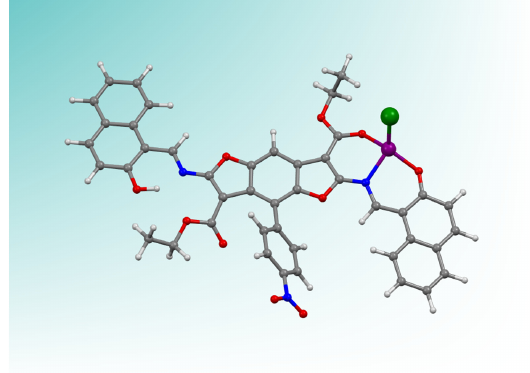
Figure 1. ZnNB model complex as a ball-and-stick representation (zinc–purple sphere). The zinc coordination sphere is based on the analogous X-ray structure of a ligand complex with zinc [30]. The green sphere represents a chloride anion, completing the tetrahedral zinc ion coordination. Figure was generated with “Mercury” [56] for rendition purposes only, and neither derived from experimental determination nor theoretical calculation.